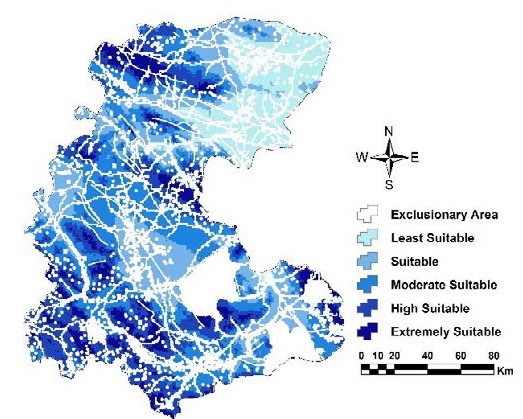
Fig. 7: Final map in fuzzy analytic hierarchy process in Markazi province